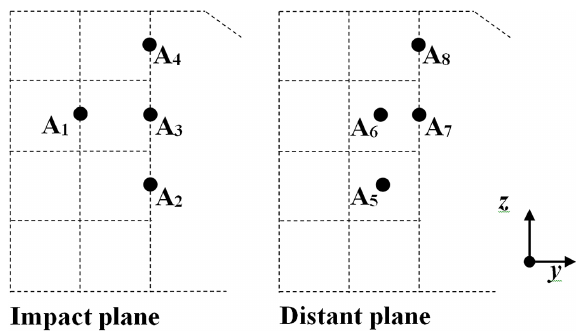
Figure 4. Accelerometers considered in this study.